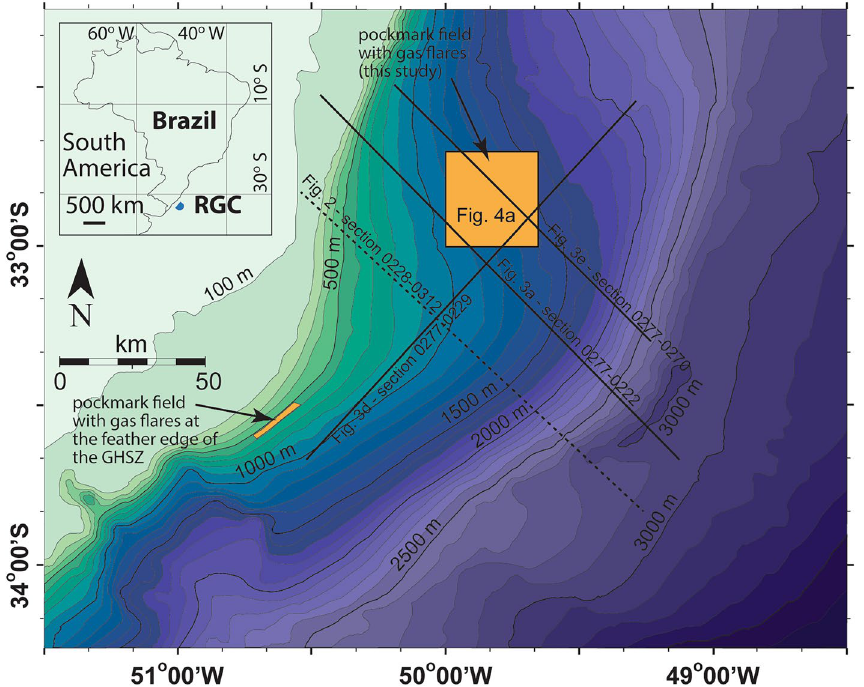
Figure 1. Bathymetric map obtained from a previous study in the area 37 showing the location the Rio Grande Cone (RGC; inset) and seismic profiles used in this study (solid lines). The dashed line shows the location of the interpreted section in Fig. 2 showing the main structural framework of the RGC. Note the areas with the two pockmark fields previously recognized in the RGC 38 (orange polygons). The depth range of the feather edge of the gas hydrate stability zone (GHSZ) is 550–585 m 37